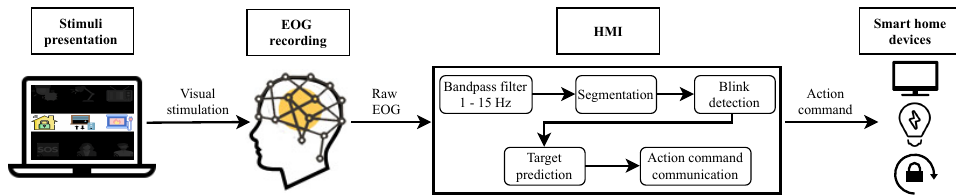
Figure 2. Electrooculography (EOG) system based on eye